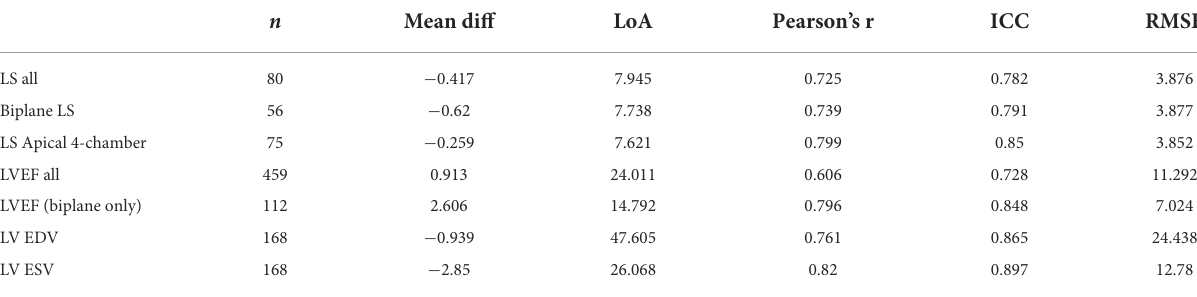
TABLE 2 Agreement between automated metrics of LV function and values derived at the time of limited transthoracic echocardiogram. n Mean diff LoA Pearson’s r ICC RMSE